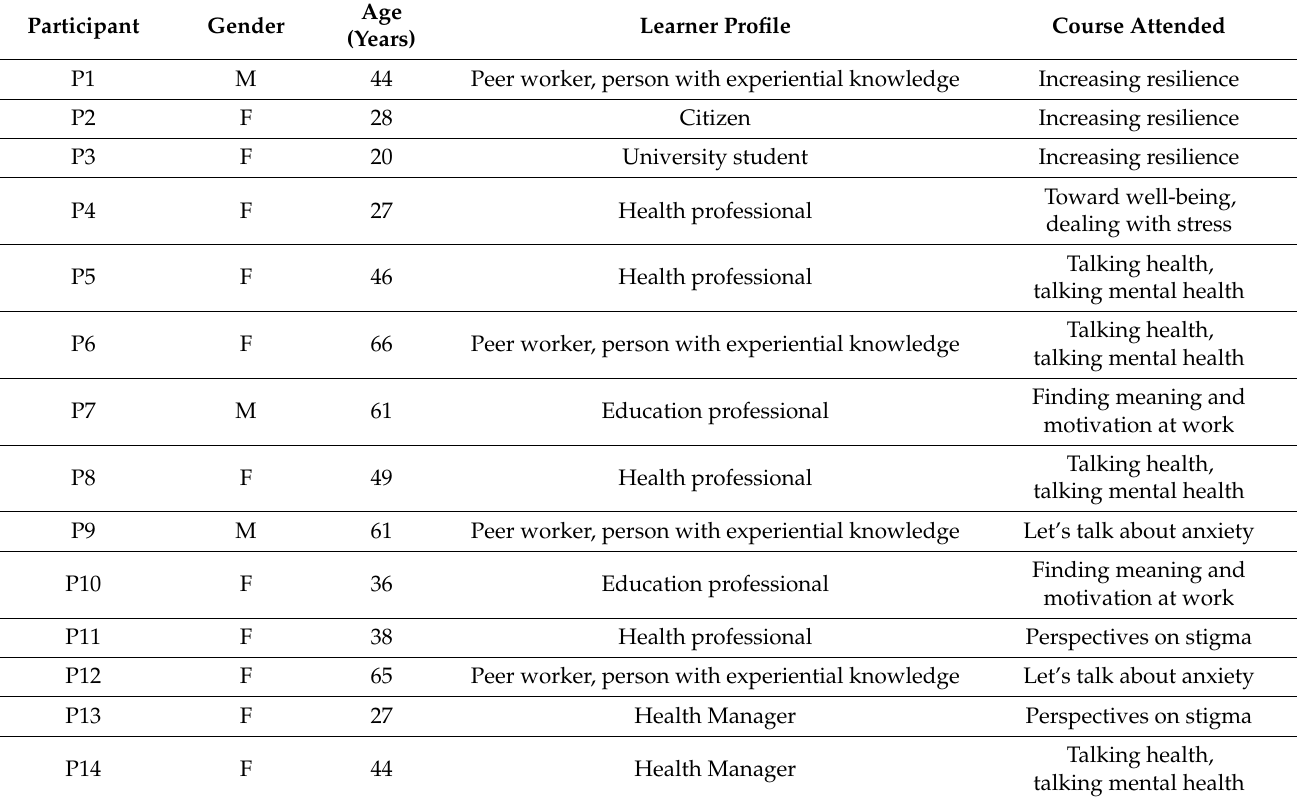
Table 2. Participants’ characteristics ( n =